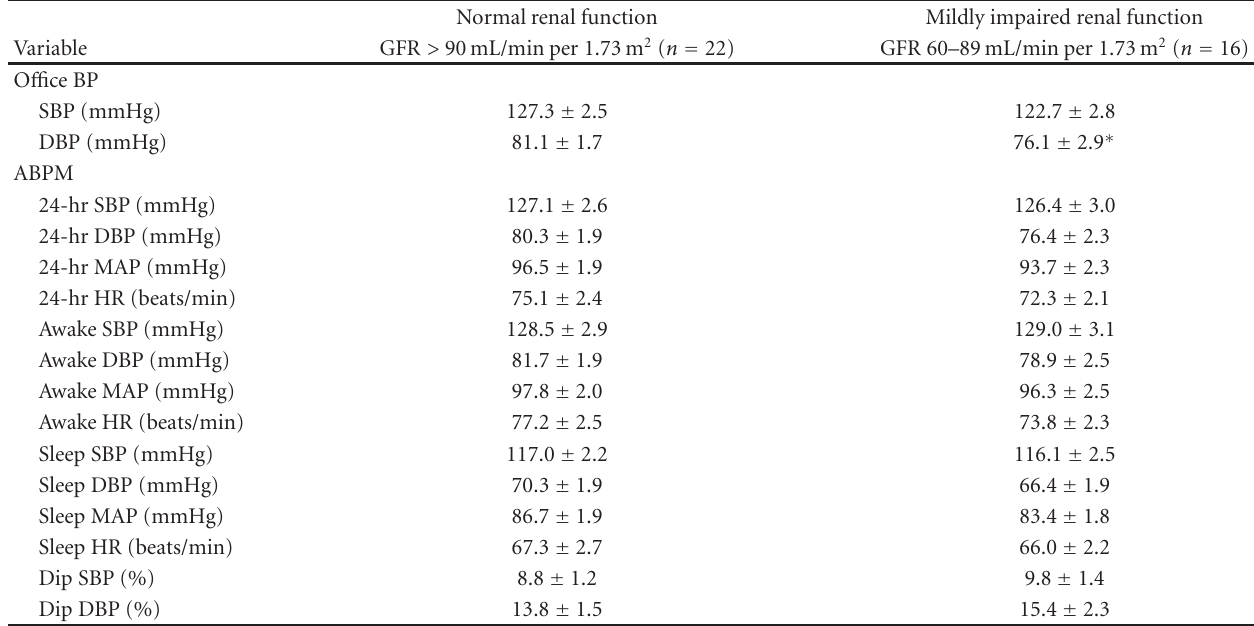
Table 2: Mean BP levels from o ffi ce and ABPM measurements in normal and mildly impaired renal function groups. Normal renal